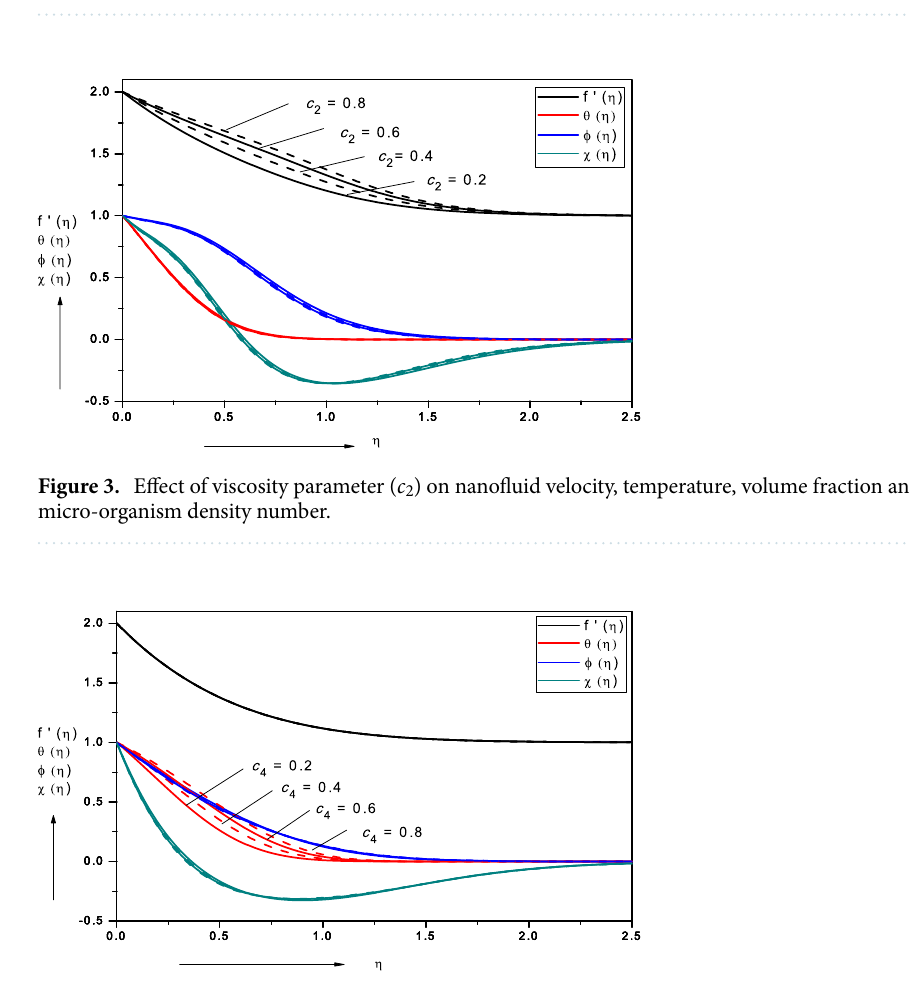
Figure 2. Variation of reduced density number of the motile micro-organisms ( Nnr ) with micro-organism diffusivity parameter ( c 8 ) in water-based nanofluid.